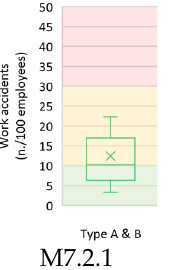
Figure 10. Results of the validation applied to the wastewater utilities: objective 6.